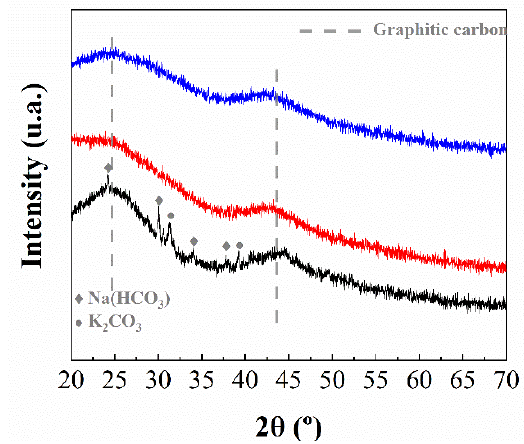
Figure 2. X-ray diffraction of the chitosan with different textural properties pyrolyzed at 900 °C: Chi-P-900 (black), Chi-F-900 (red) and Chi-G-900